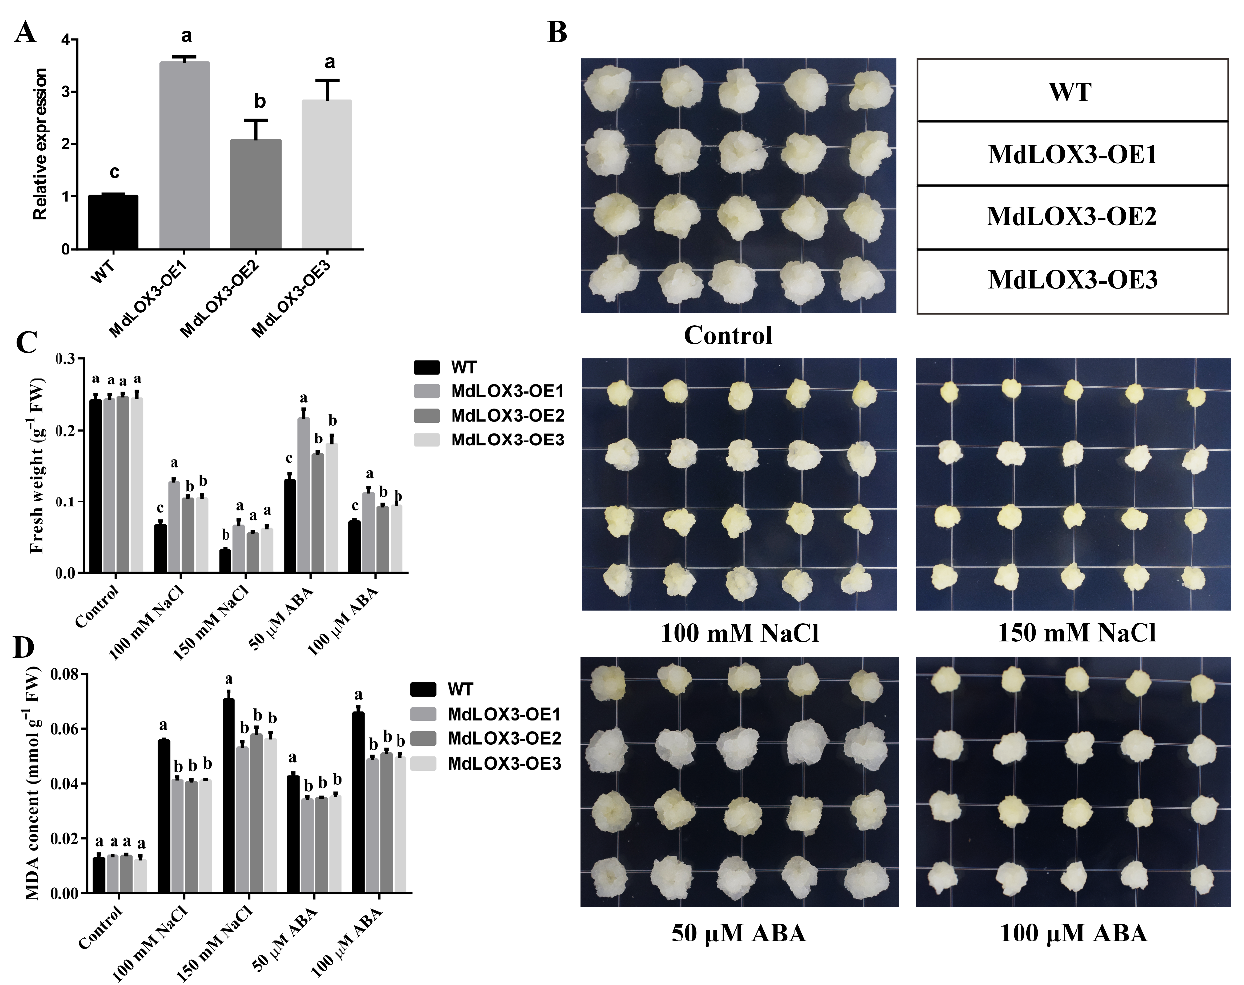
Figure 4. MdLOX3 improves the resistance of apple calli to NaCl and ABA. ( A ) qRT-PCR analysis of MdLOX3 transcript level in WT and transgenic calli. ( B ) The growth phenotypes of WT and MdLOX3-OE cultured on MS medium containing different concentrations of NaCl (100 and 150 mM) or ABA (50 and 100 µ M) for 15 days. Fresh weight ( C ) and MDA content ( D ) of WT and MdLOX3-OE . Error bars, ± SD of three independent replicates. Different lowercase letters represent significant differences ( p < 0.05).